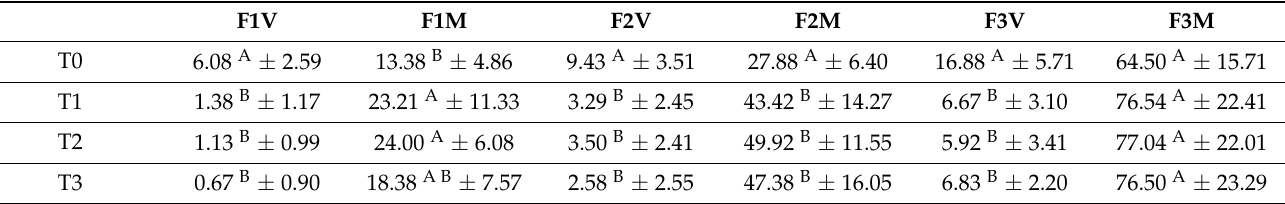
Table 4. Survival (V) and mortality (M) of Parlatoria ziziphi females (F1, F2, and F3) treated with different doses of spirotetramat (T0 = 0 L/ha, T1 = 0.625 L/ha, T2 = 0.755 L/ha, and T3 = 1